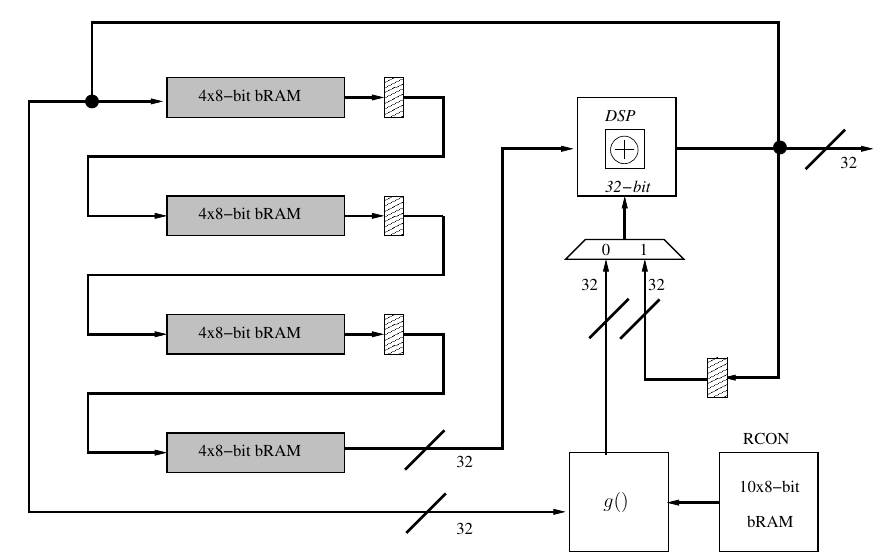
Figure 2. Proposed organization for the key